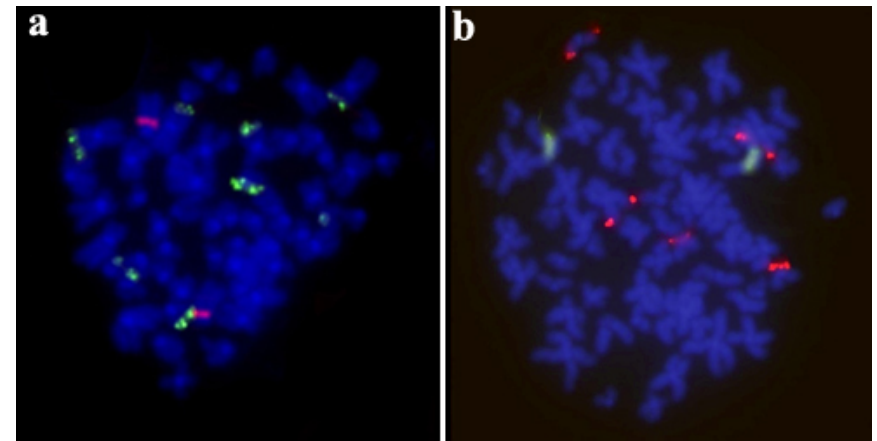
All the Potamotrygon sp. individuals analyzed had a karyotype with 2n=66 chromosomes, with the karyotype formula varying among individuals, which were either 21m + 10sm + 6st + 29a or 22m + 9sm + 6st + 29a (Figure 1C and 1D). This variation was due to presence of chromosomes